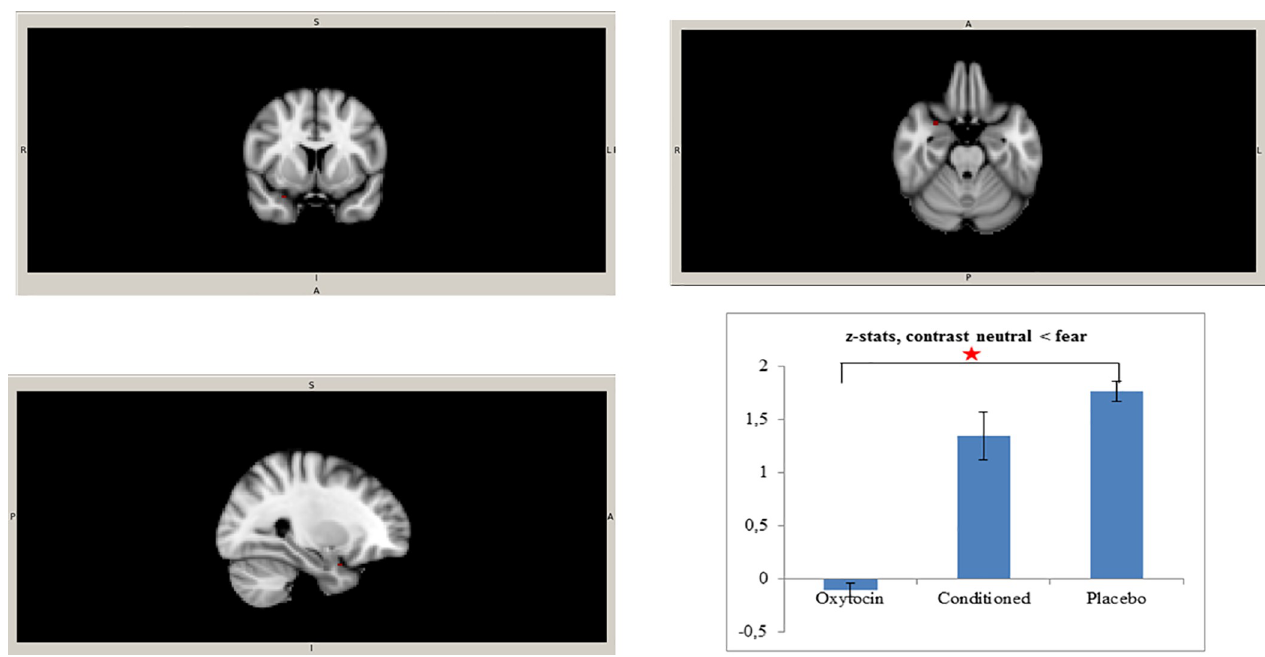
Fig 2. Cluster in right amygdala, contrast neutral < fearful. Cluster (28, 8, -24; t max = 3.81, cluster size = 4) with the significantly lower activation in the oxytocin group in comparison to the placebo group on the contrast neutral < fearful and Z statistics with standard deviations from this cluster.